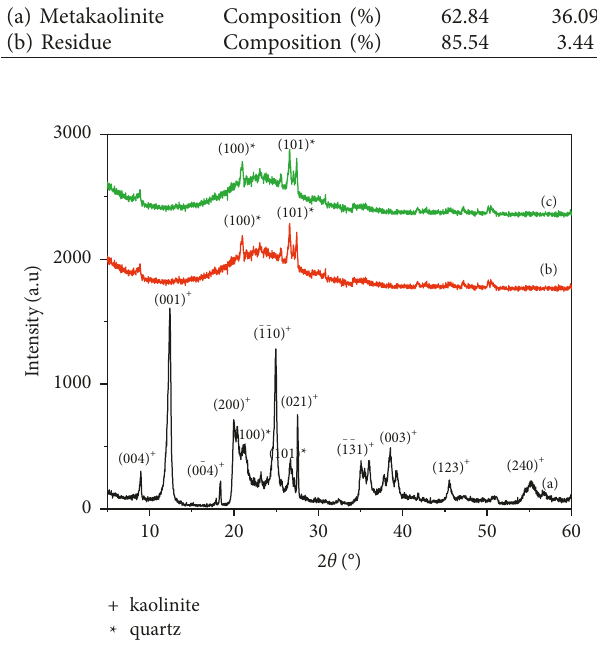
Figure 5: XRD peaks of (a) kaolinite, (b) metakaolinite at 700 ° C for 180min, and (c) residue after leaching at 0.10g · mL − 1 , 5M, 80 ° C, and 180min.